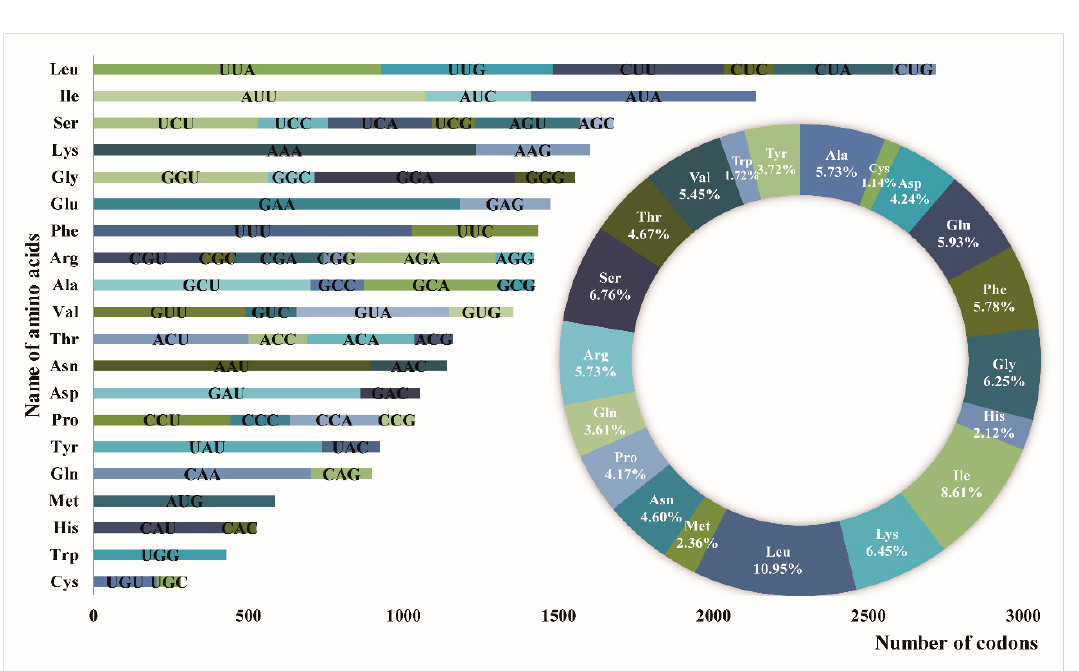
Figure 2. Codon usage and amino acid frequencies in the F. hodginsii cp genes. The composition of amino acids and the quantities of codons are listed in the bar chart. The frequencies of amino acids were calculated for all of the 83 protein-coding genes from the F. hodginsii cp genome shown in the pie chart.